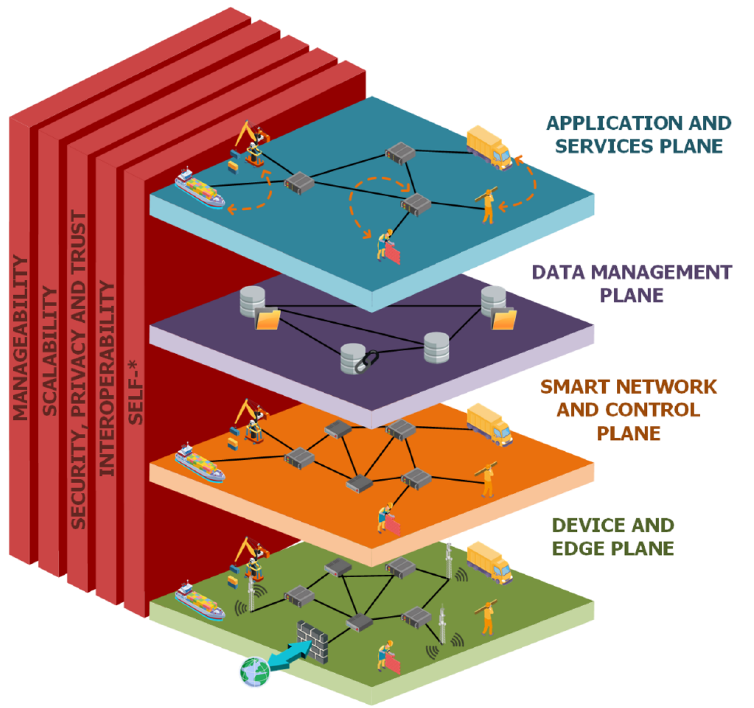
Figure 1. ASSIST-IoT layers and verticals—an